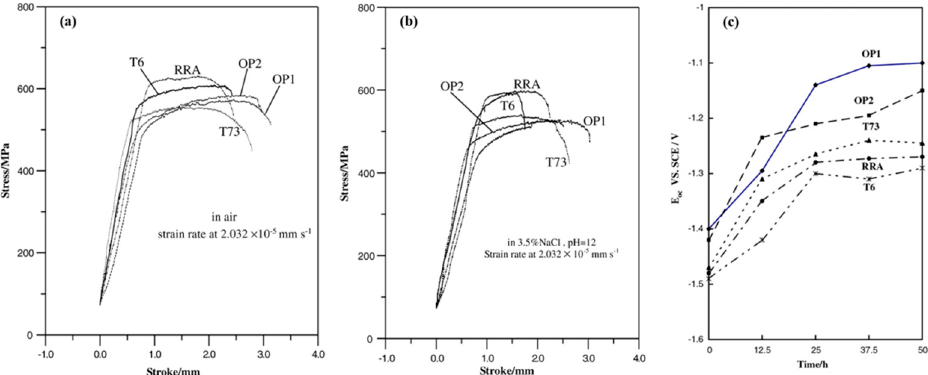
Figure 21. SSRT results of 7050 with different aging regimes ( a ) in air ( b ) in 3% NaCl solution; ( c ) Variation of corrosion potential with time for various specimens in 3.5% NaCl solution at pH12. (Reprinted with permission from ref. [138]. Copyright 2006 Elsevier).